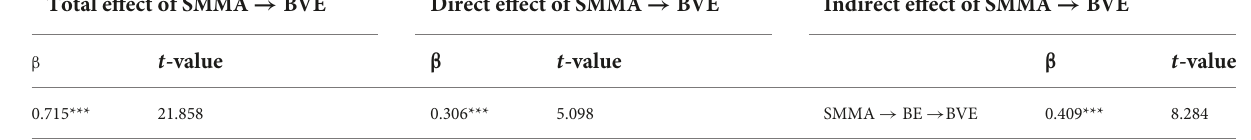
TABLE 9 Mediation test